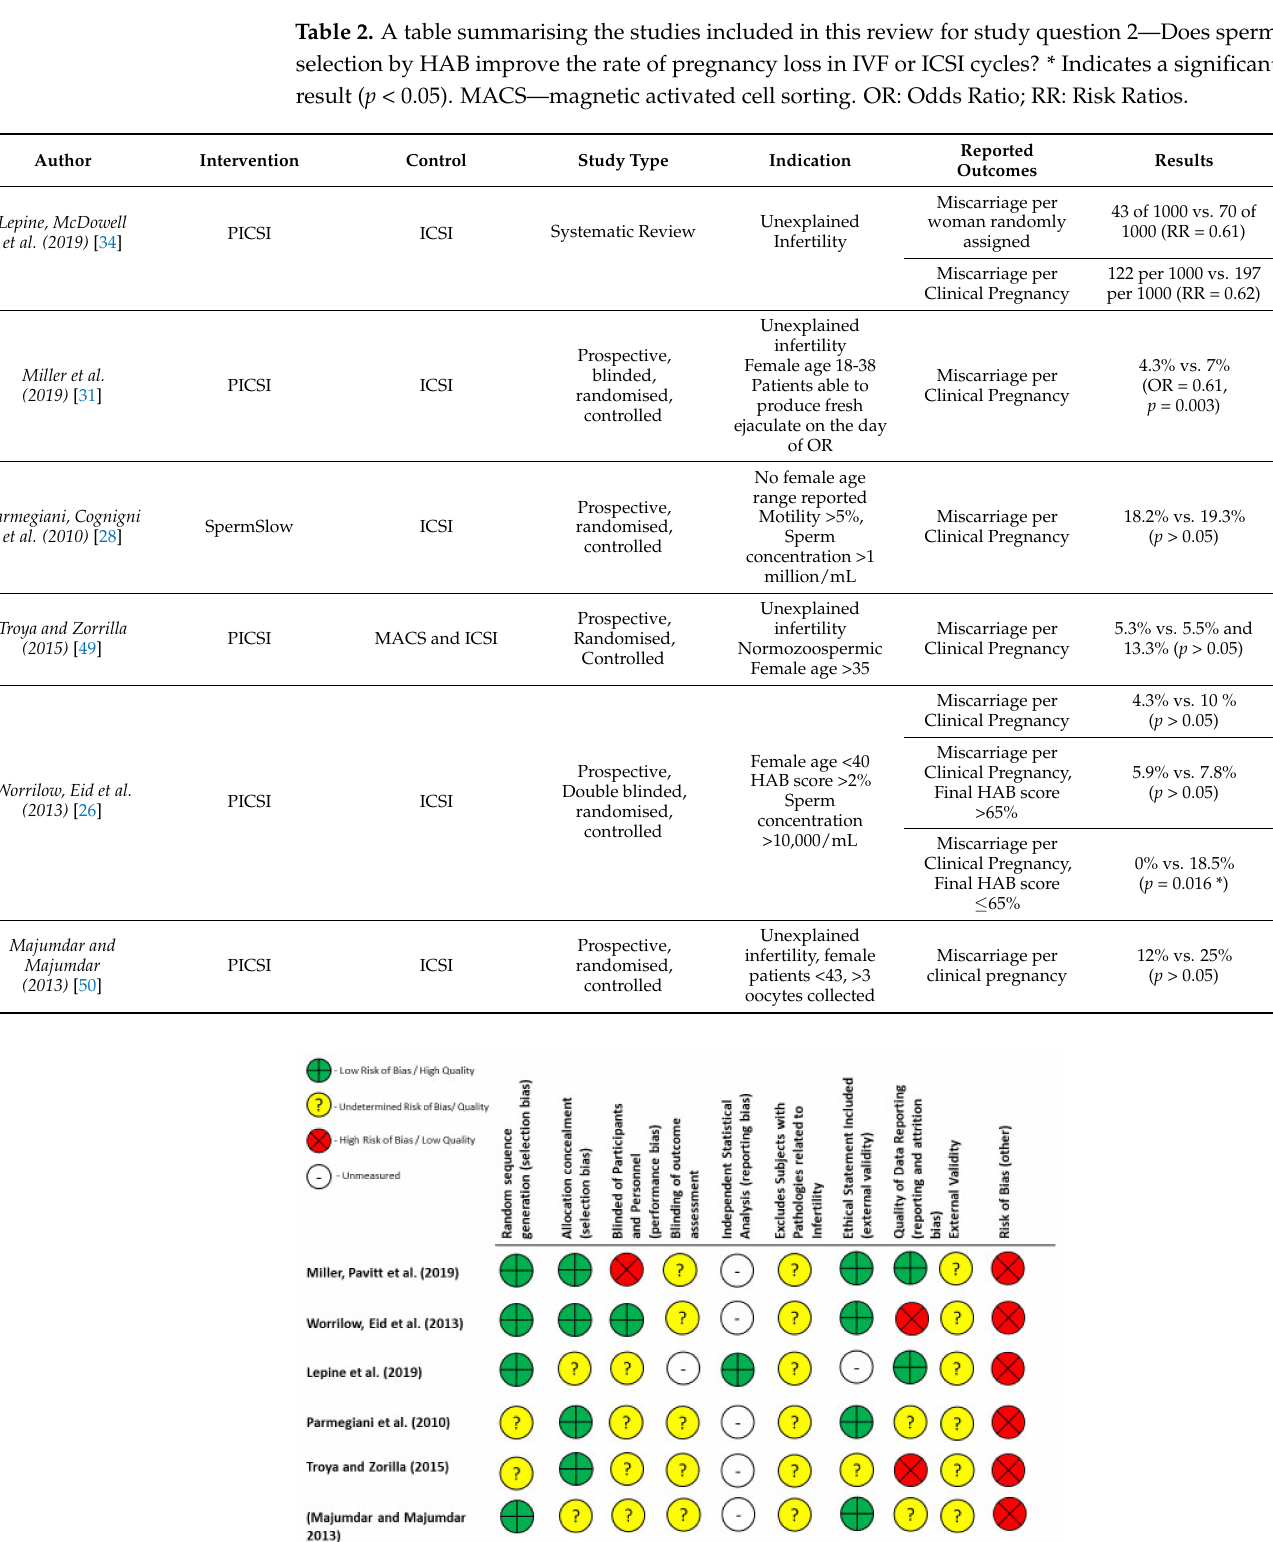
Figure 5. A summary of the authors’ judgement on quality and bias assessment results on the 5 studies included in study question 2—Does sperm selection by HAB reduce the rate of pregnancy loss in IVF or ICSI cycles? Green: low risk of bias/high quality, Yellow: undetermined risk of bias/quality, Red: high risk of bias/low quality, White: assessment does not apply.